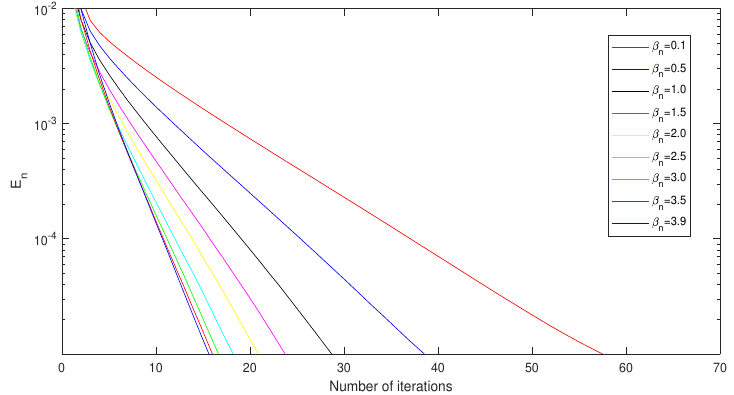
Figure 8. Graph of number of iterations versus E n in case N = 4096 and M =